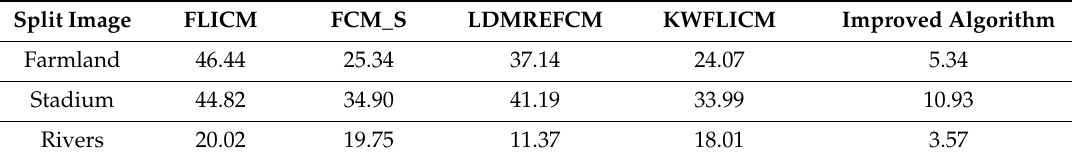
Table 12. The MCR (%) comparison against anti-mixed noise between each algorithm. Split Image FLICM FCM_S LDMREFCM KWFLICM Improved Algorithm